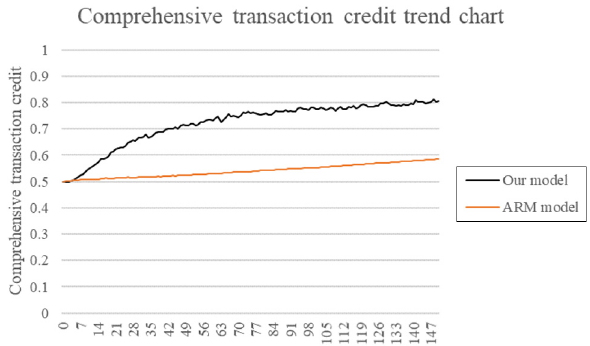
Figure 8. Comparison with ARM